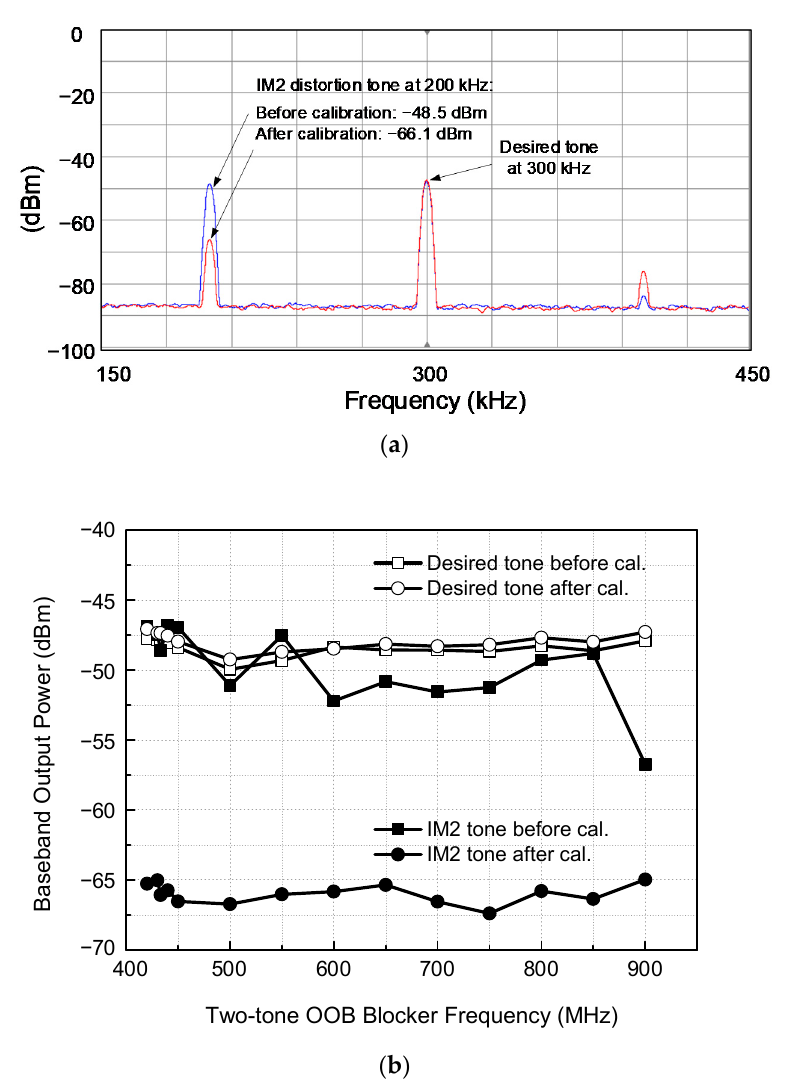
Figure 12. IM2 calibration performance measurements. ( a ) Spectrum, ( b ) results over the UHF band.